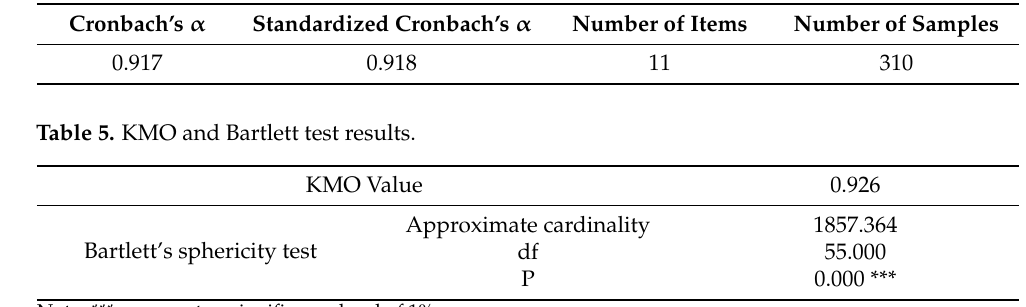
Table 4. Cronbach reliability analysis.